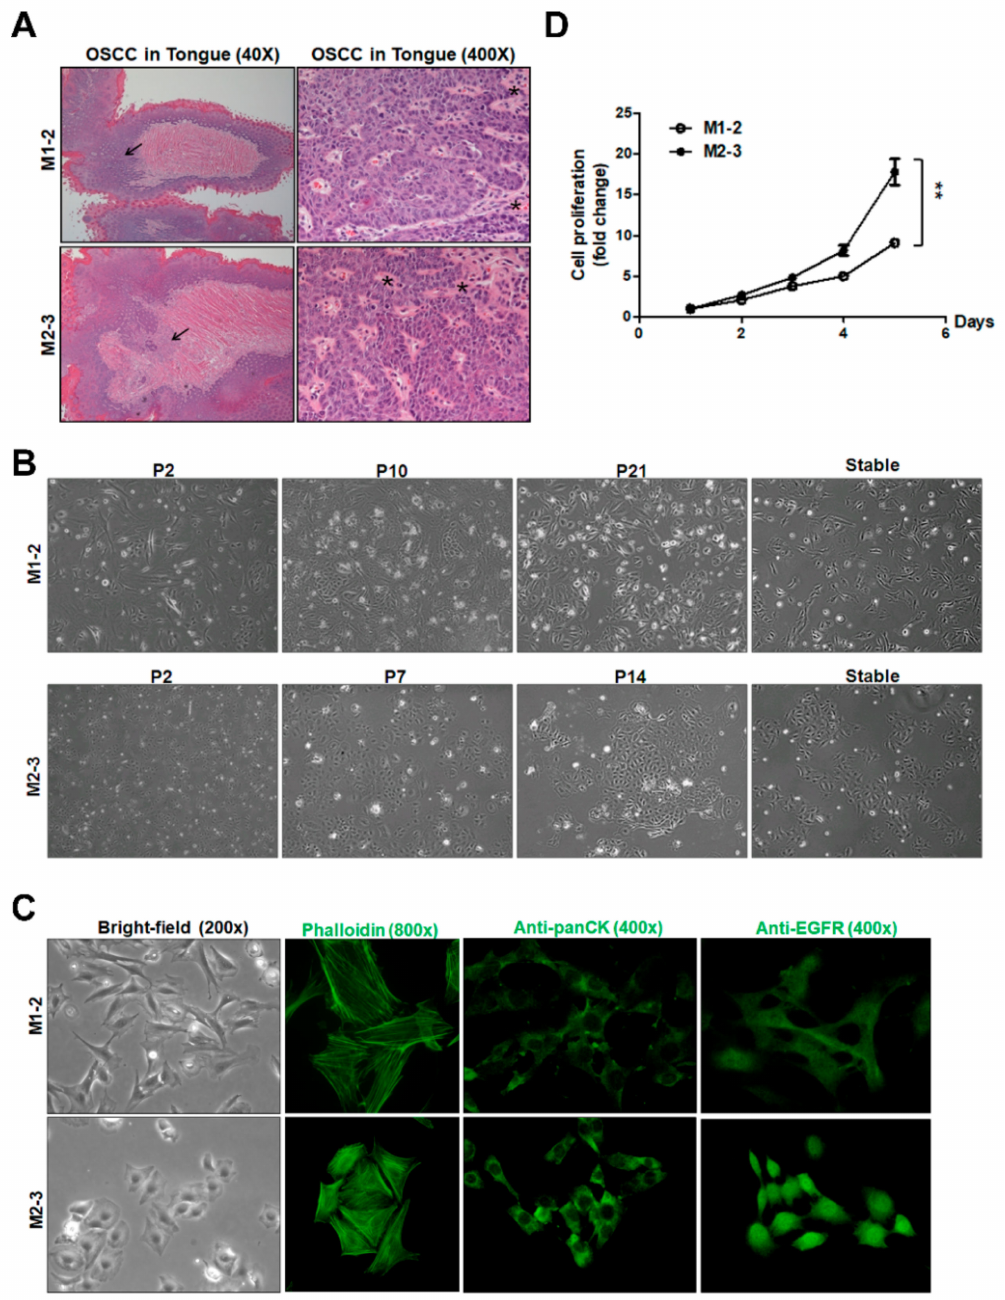
Figure 1. Establishment of two mouse oral squamous cell carcinoma (OSCC) cell lines from carcinogen-induced tongue tumors. ( A ) Histological examination of the carcinogen-induced tongue tumors at 40 × (left panel) and 400 × (right panel) magnifications. Black arrows indicate the tumor parts. Asterisks (*) indicate the representative keratinization and keratin-pearl formation. ( B ) Cell morphology of M1-2 and M2-3 cells at di ff erent passages at 100 × magnification. ( C ) Representative images of cells at 200 × magnification (left panel). Phalloidin (middle left panel), Pan-CK (middle right panel) and epidermal growth factor receptor (EGFR) staining (right panel) in M1-2 and M2-3 cells at 400 × or 800 × magnification. ( D ) A representative cell growth curve obtained by MTS assay in M1-2 and M2-3 cells. The results were expressed as the fold change to the results at day 1. Error bars represent SE; ** p <